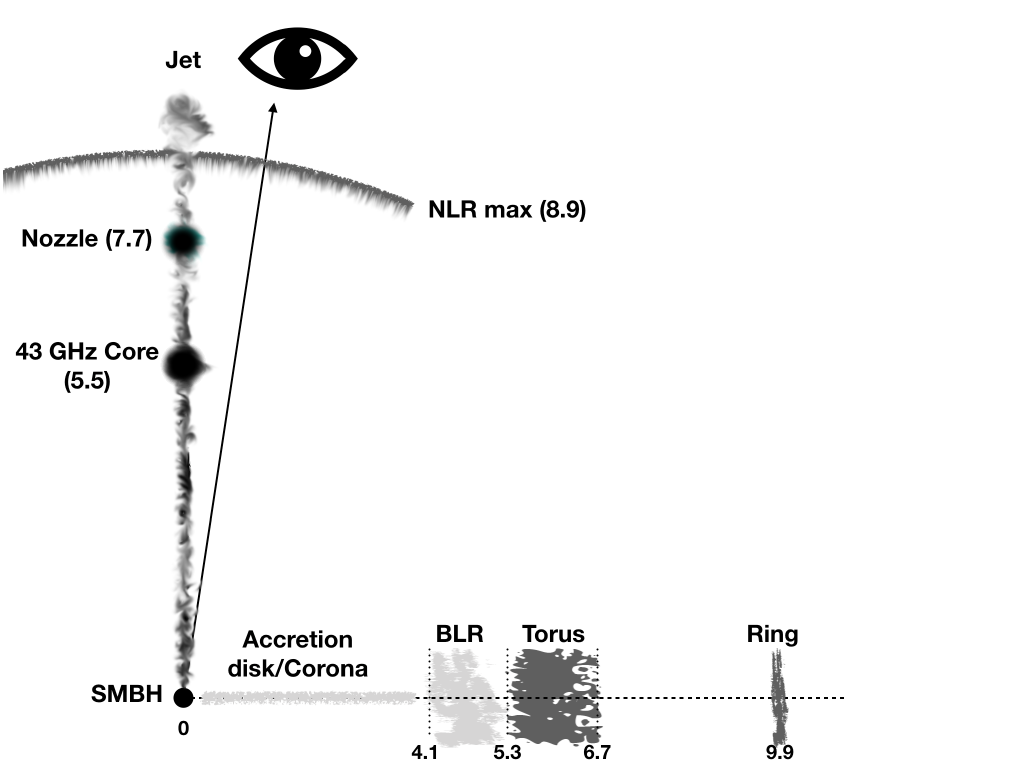
Figure 2. Schematic of the AGN J0324 + 3410. The distances (explicitly indicated with numbers) are in units of gravitational radius and in logarithmic scale (cf. Table